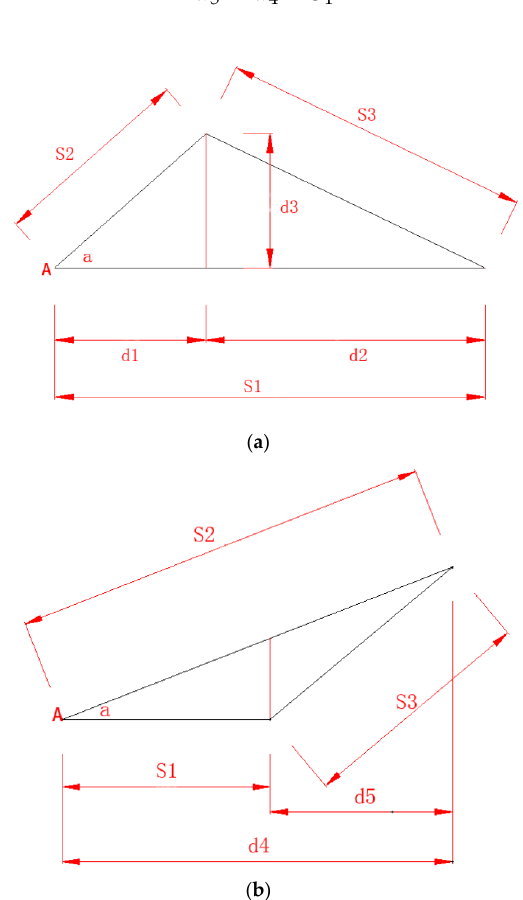
Figure 3. Algorithm for filling the triangle area with discrete balls: ( a ) 𝑆 2 ≤ 𝑆 1 ; ( b ) 𝑆 2 > 𝑆 1 .